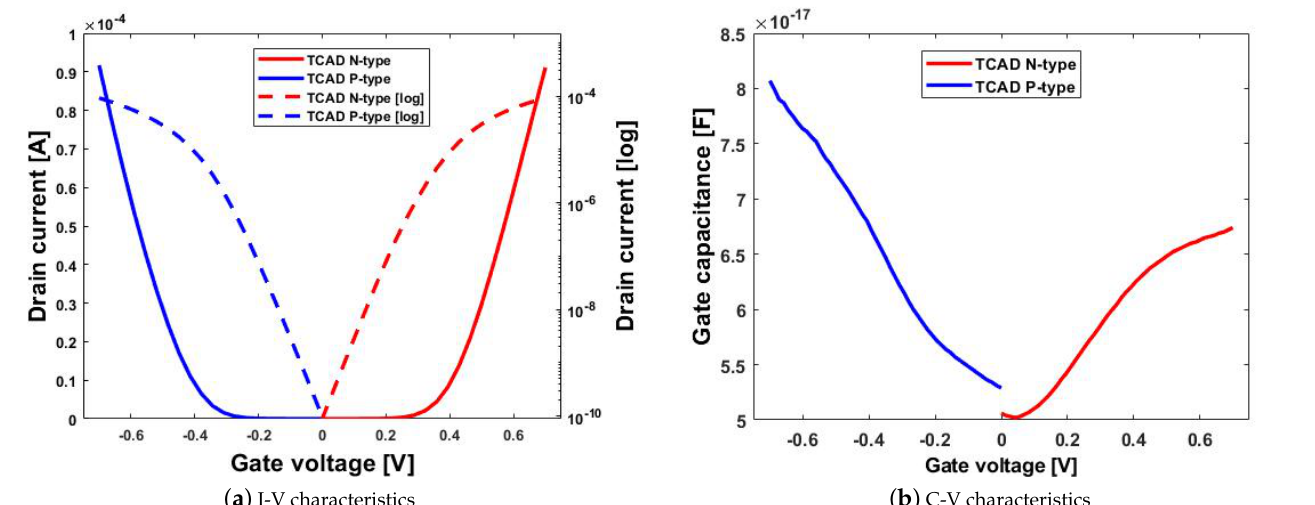
Figure 3. ( a ) I-V symmetry graph of an N-type NSFET and P-type NSFET. ( b ) Gate capacitance of an N-type NSFET and P-type